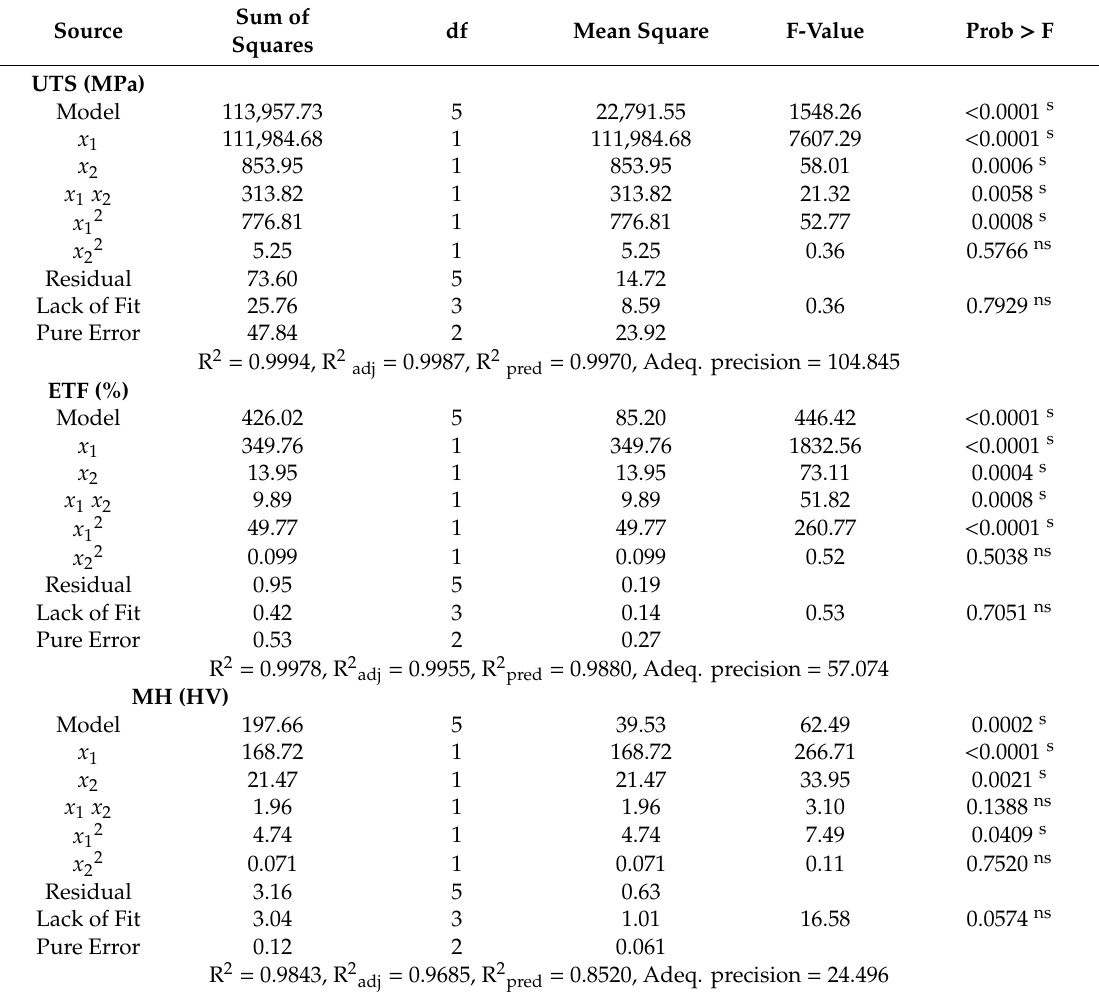
Table 4. ANOVA table (partial sum of squares) for the initial quadratic model. UTS, ultimate tensile strength; Adeq., adequate; ETF, elongation to failure; MH,